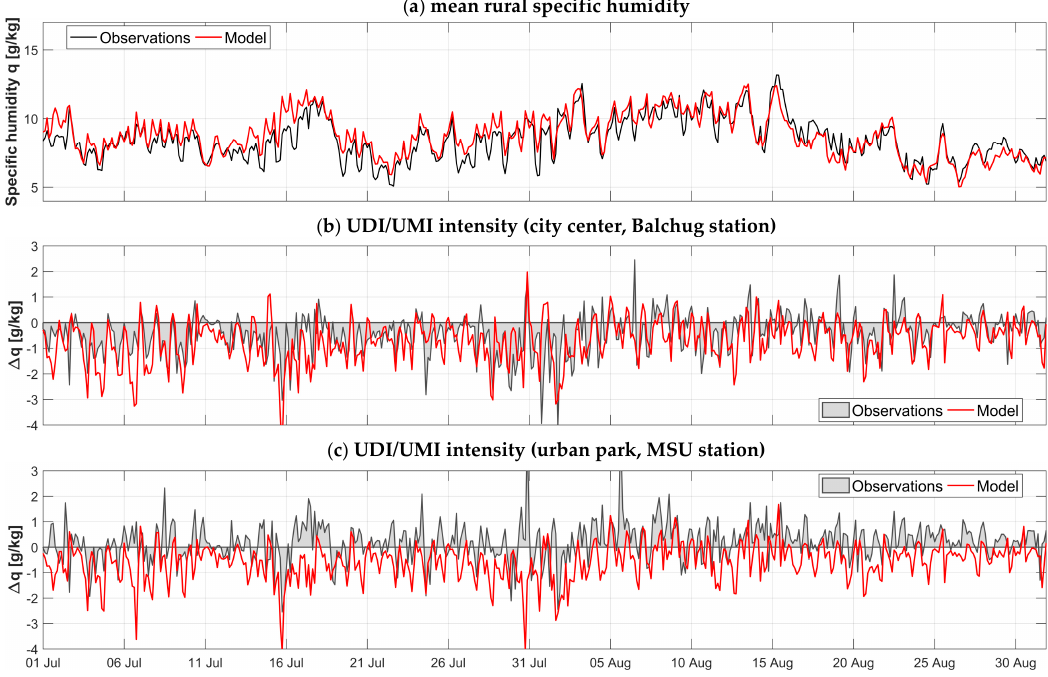
Figure 3. Same as Figure 2, for: mean rural specific humidity ( a ); and urban dry/moist island (UDI/UMI) intensity ( ∆ q ) for two urban stations ( b , c ). Positive values of ∆ q indicate UMI, negative values indicate